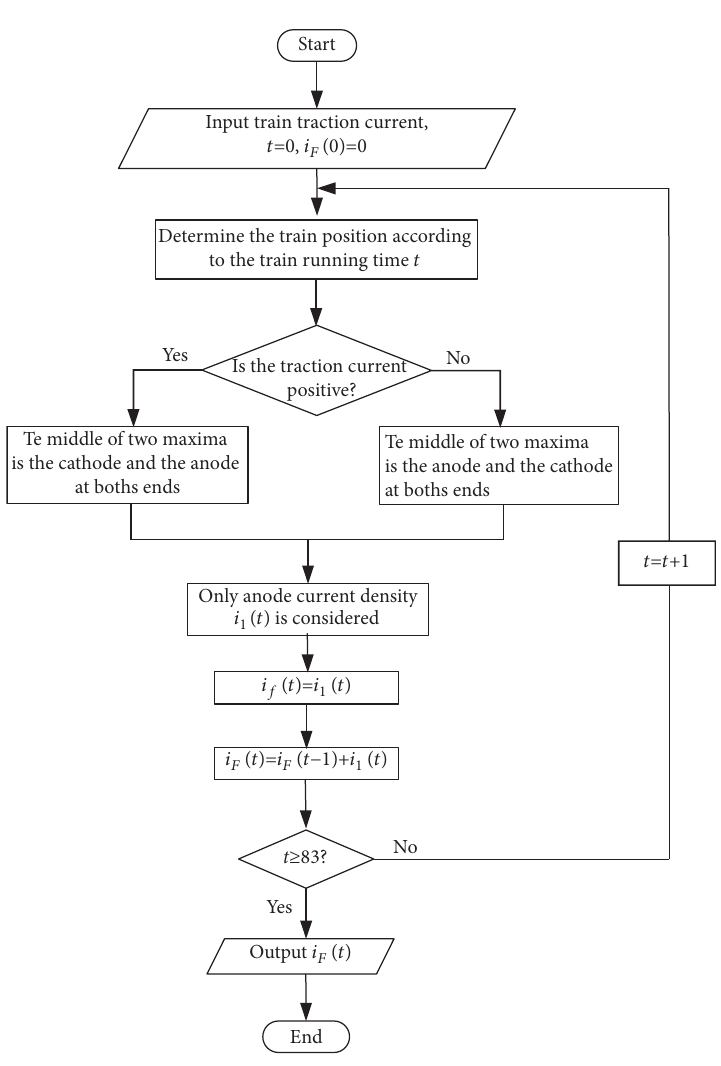
Figure 11: Flowchart for calculation of total corrosion current density of buried pipelines.